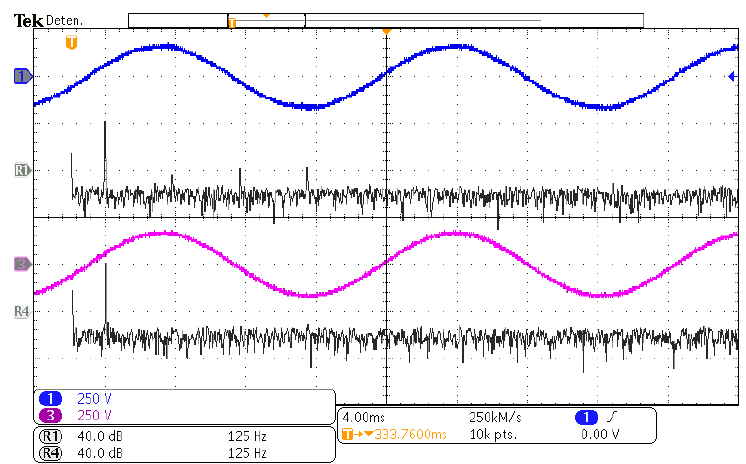
Figure 12. Steady state responses at the PCC of: (CH1) the voltage v PCC (y-axis 250 V/div, x-axis 4 ms/div); (R1) the frequency spectra of v PCC (y-axis 40 dB/div, x-axis 125 Hz/div); (CH3) the fundamental component estimate of the grid voltage v PCC,1 (y-axis 250 V/div, x-axis 4 ms/div); and (R4) the frequency spectra of v PCC,1 (y-axis 40 dB/div, x-axis 125 Hz/div).